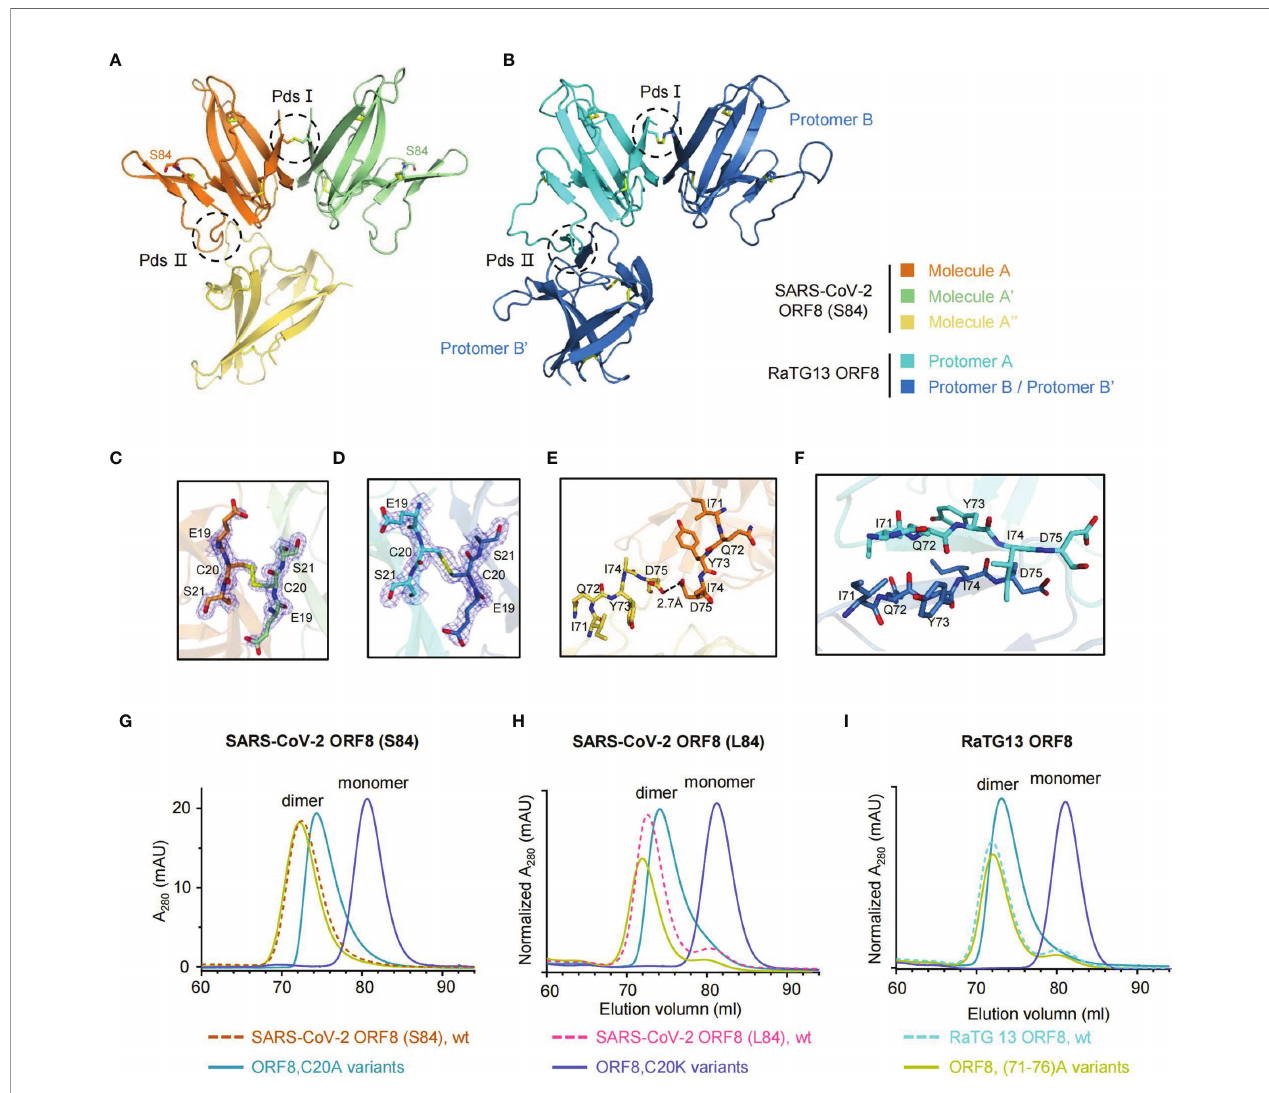
FIGURE 3 | ORF8 forms a homodimer via Cys20-Cys20 intermolecular disul fi de bond. (A, B) The symmetry mates of SARS-CoV-2 ORF8 (S84) (A) and RaTG13 ORF8 (B) are generated by PyMOL software, respectively. Putative dimer surfaces (Pds) are highlighted in dashed circles. PdsI, the C20-C20 covalent disul fi de interface; PdsII, the putative noncovalent interface. (C, D) Stick representation of PdsI in SARS-CoV-2 ORF8 (S84) (C) and RaTG13 ORF8 (D) with 2Fo-Fc electron density map contoured at 1.2 s . Disul fi de bonds are presented in yellow. (E, F) Stick representation of PdsII in SARS-CoV-2 ORF8 (S84) (E) and RaTG13 ORF8 (F) . (G – I) SEC analysis of SARS-CoV-2 ORF8 (S84) (G) , ORF8 (L84) (H) , and RaTG13 ORF8 (I) mutants (HiLoad 16/600 Superdex 75 pg column). The elution pro fi les of ORF8 mutant variants are shown as full-lines and and the ORF8 wild-type variants are shown as dash lines (HiLoad 16/600 Superdex 75 pg column). mAU, milliabsorption units. Normalized A280 indicated that the mAU values has normalized with input protein